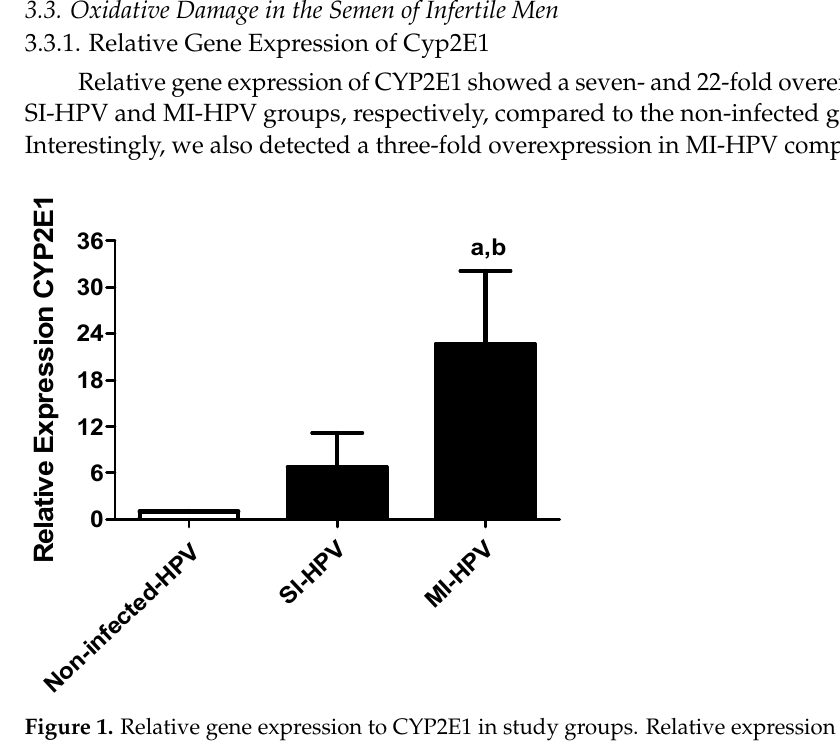
Table 3. Oxidative stress biomarkers in semen